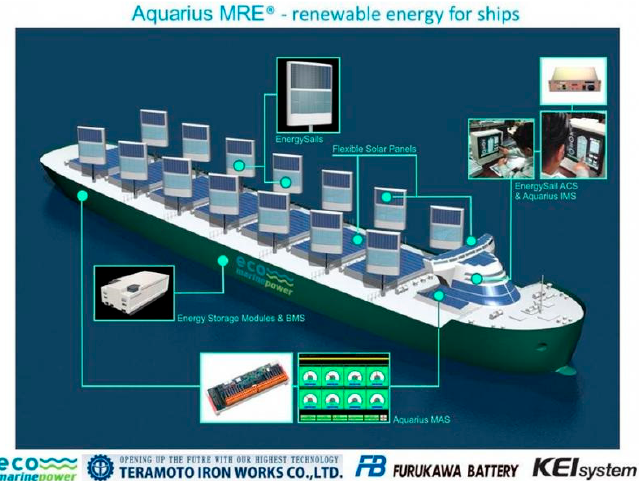
Figure 5. Aquarius Marine Renewable Energy MRE [50], © 2019 Eco Marine Power Pty. Ltd.